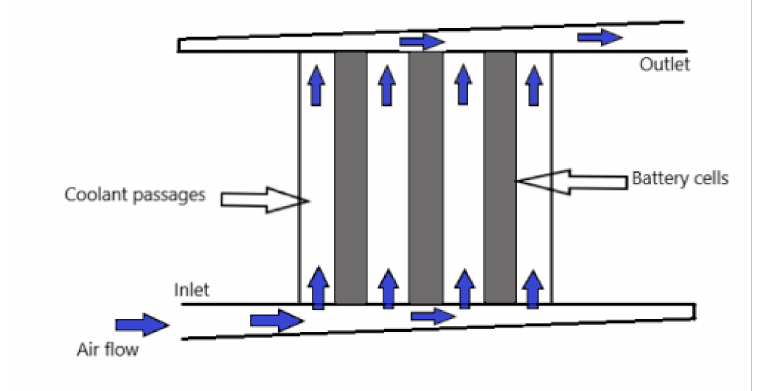
Figure 5. Schematic of the air-cooling system for Li-ion battery